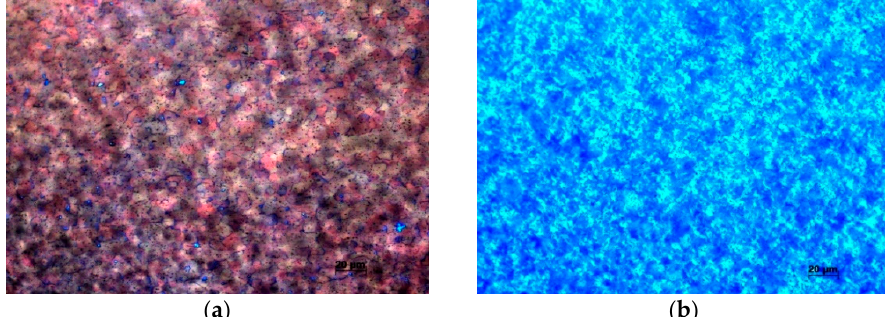
Figure 1. Metallographic structure of Zircaloy-4 (bar) ( a ). longitudinal section; ( b ). cross section.